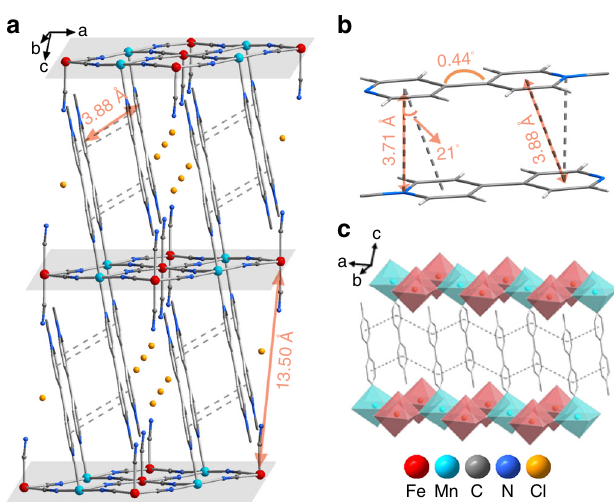
Fig. 2 Crystal structure of 1. a Side view of the 3-D packing structure; b two π -stacked MQ + cations; c in fi nitely π -stacked MQ + cations between two perovskite-like cyanide-bridged layers (cyano groups are drawn as vertexes of octahedra). Dash lines depict π stacking